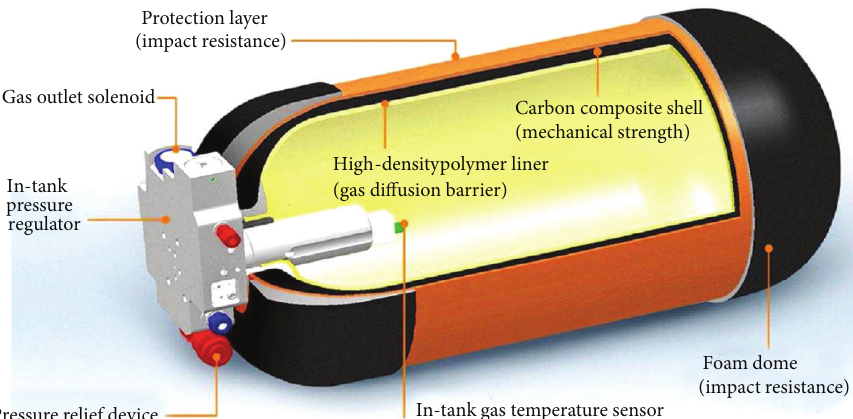
Figure 5: Schematic diagram of a type 4 pressure vessel and its components for gaseous hydrogen storage (Quantum Technologies, Inc., Irvine). Reprinted from [26], with permission from Elsevier.